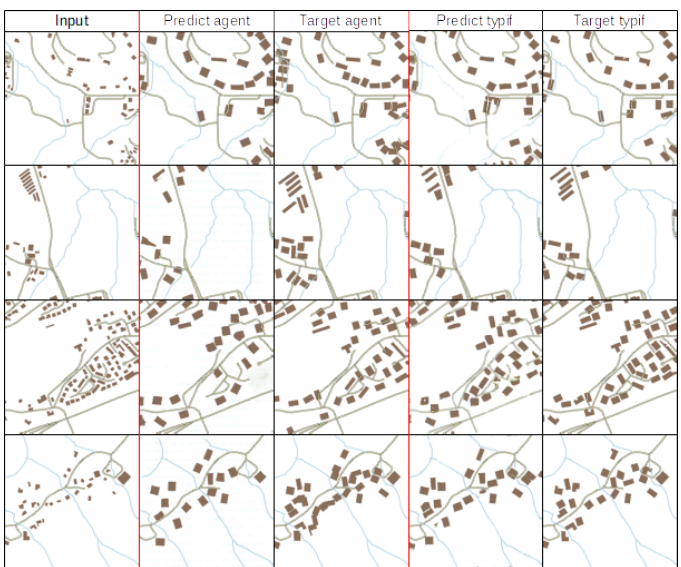
Figure 3. Comparison of images generated by pix2pix trained with agent-based generalisation, and typification-based generalisation.